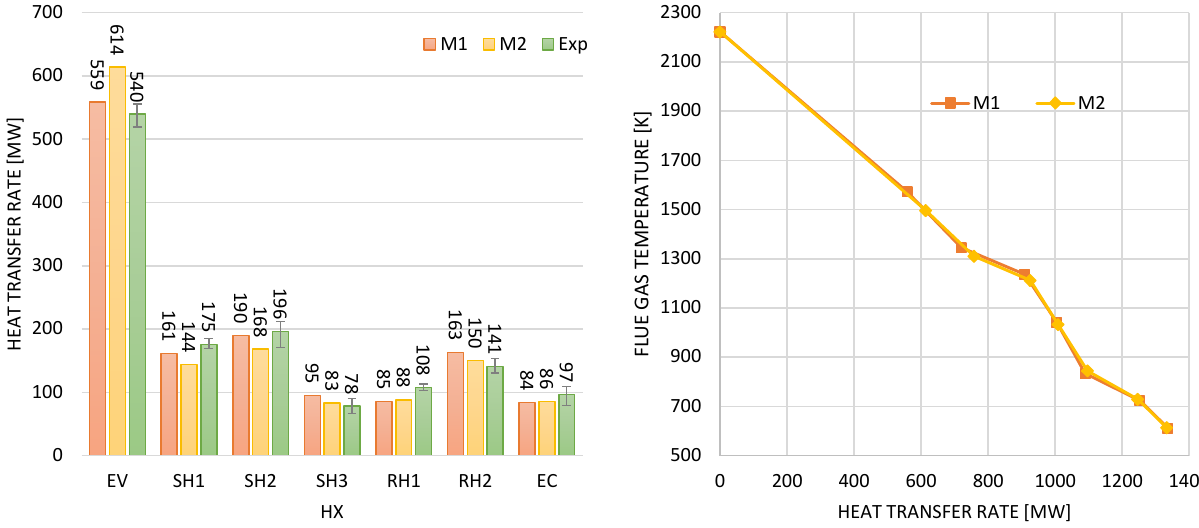
Figure 7. Calculated and measured heat transfer rates to different heat exchanger components ( left ); Q-T diagram for two modelling approaches ( right ) for the utility-scale coal-fired boiler model. The results show that M1 and M2 overpredict the EV heat load, i.e., the furnace heat transfer rate, by 3.5% and 13.7%, respectively. The furnace exit gas temperature calculated using the CFD model (Figure 5 right) is 1678 K, whereas the furnace exit gas